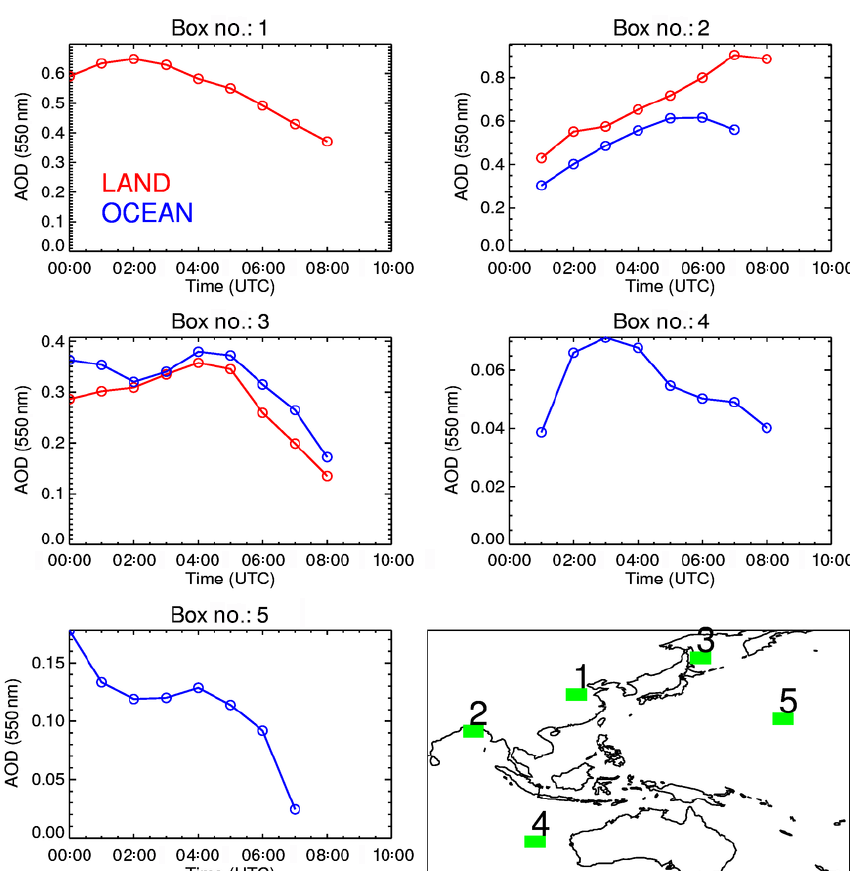
Figure 12. Spatially averaged mean AOD at 550nm from the derived DT AHI product for selected 5 ◦ by 5 ◦ latitude–longitude squares (boxes) in each hourly bin for the 2-month study period, producing AOD diurnal signatures for these selected areas. Red lines depict overland retrievals. Blue lines depict over-ocean retrievals. The x axes are in UTC hours, for the reference; the local time in Beijing is + 8h from UTC. The y axis scale varies from plot to plot. The green squares on the global map indicate location of the specific